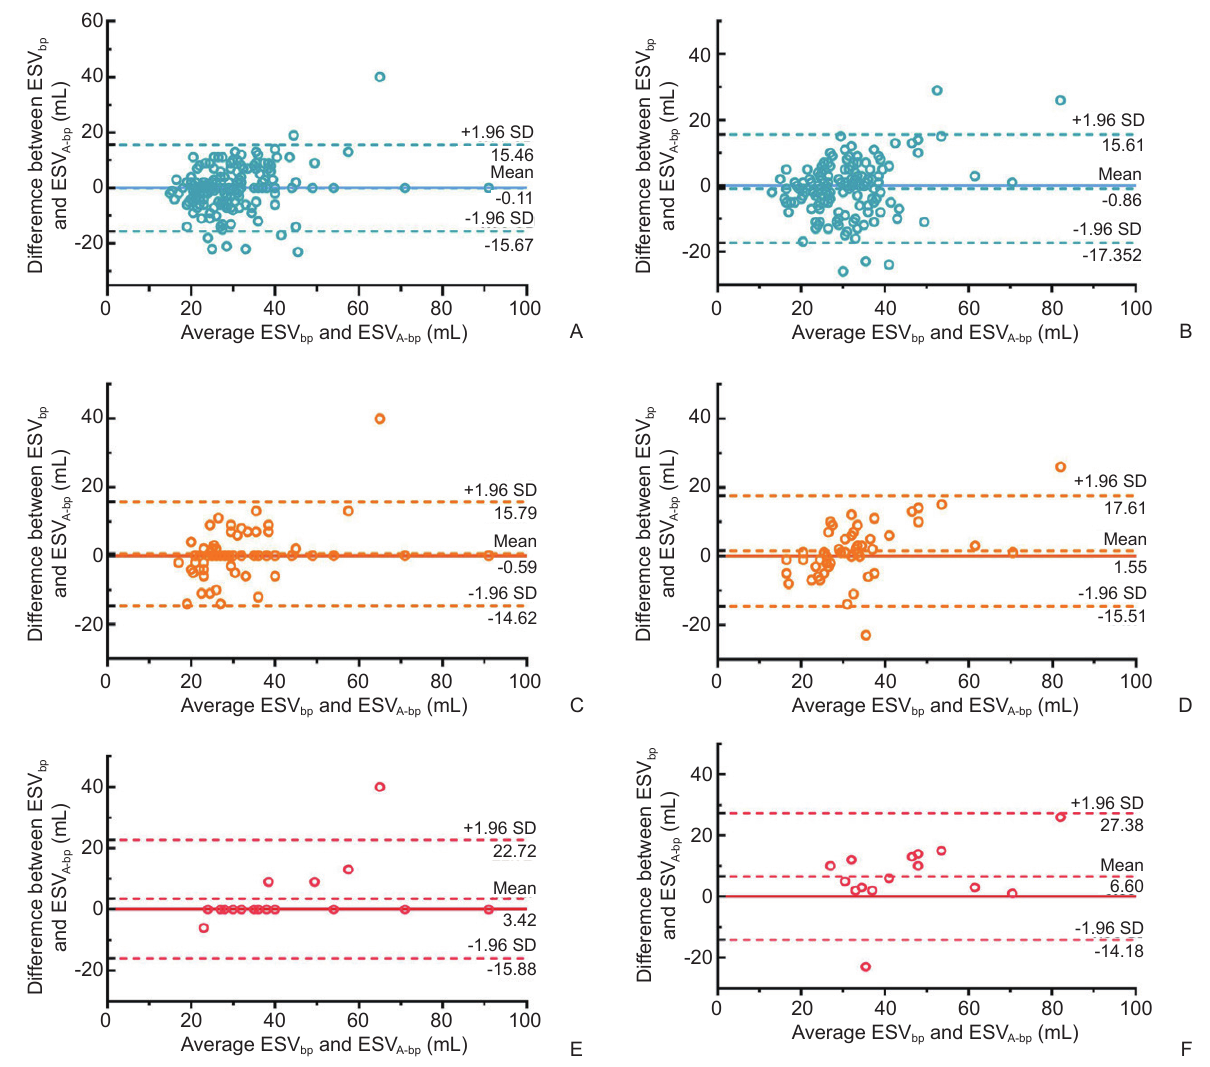
Figure 6 Bland–Altman analysis of ESV between different methods in different image quality group. (left) The good quality group and (right) poor quality group for manual ESV vs. automated ESV in the common group (A and B), CHD group (C and D), WMA group (E and F). CHD, cardiac heart disease; WMA, wall motion abnormalities; ESV, end-systolic volume; ESV bp was parameter by manual method; ESV A-bp was parameter by automated method. Table 4 Repeatability analysis of manual method ( n = 36) Intra-observer variability Inter-observer Biplane views